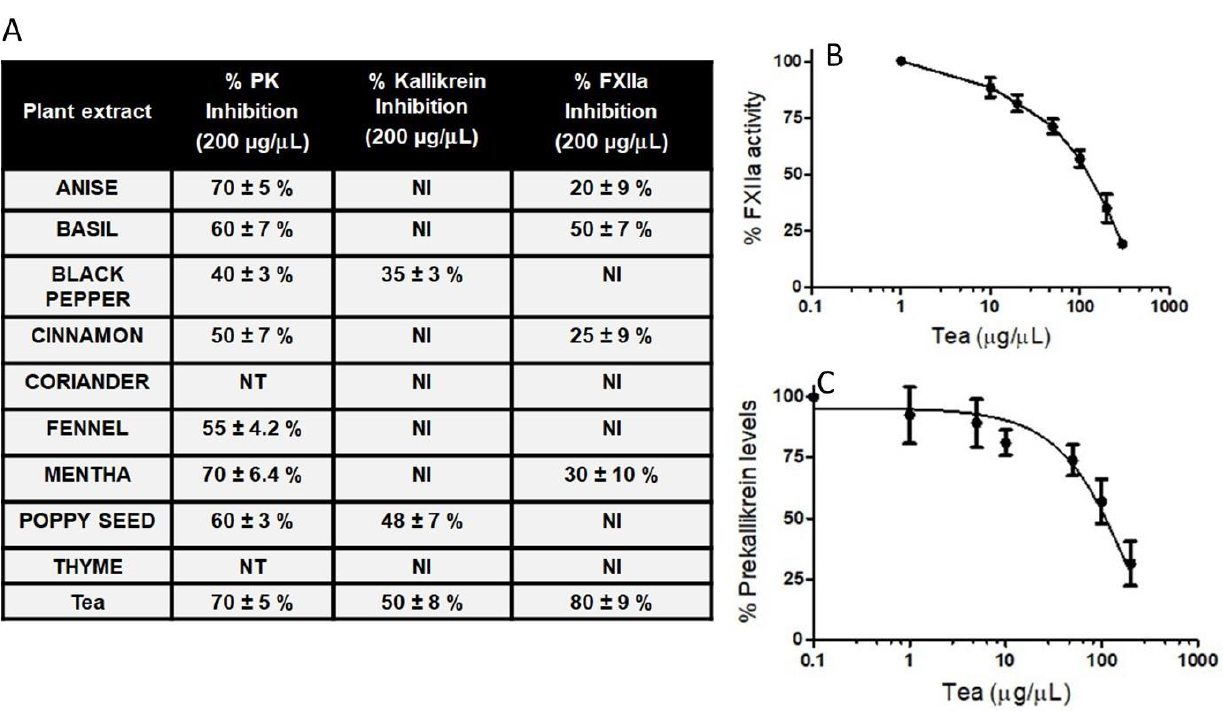
Figure 3. Effect of black tea water extract on activated FXII, plasma kallikrein activity, or the activation of prekallikrein (PK). Increasing concentrations of black tea water extract were incubated with activated FXII ( A , B ), kallikrein ( A ), or a mixture of high-molecular-weight kininogen (HK) and PK (HK/PK) on HAEVC ( C ) and S2302 (0.5 mM) for 1 h at 37 °C. For all panels, data are means for three independent experiments. NI; denotes no inhibition. NT; not tested.